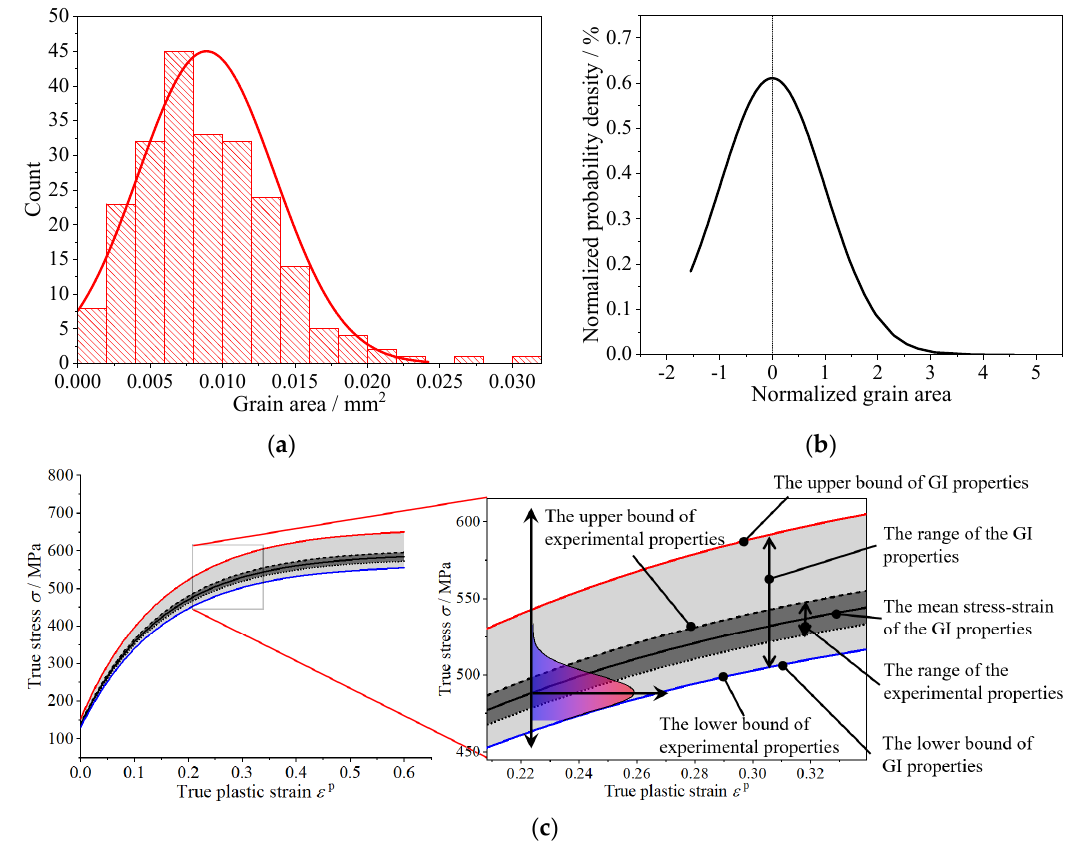
Figure 3. The process of generating GI stress ‐ strain curves: ( a ) GI area distribution; ( b ) Normalized distribution; ( c ) Upper and lower limits of GI.